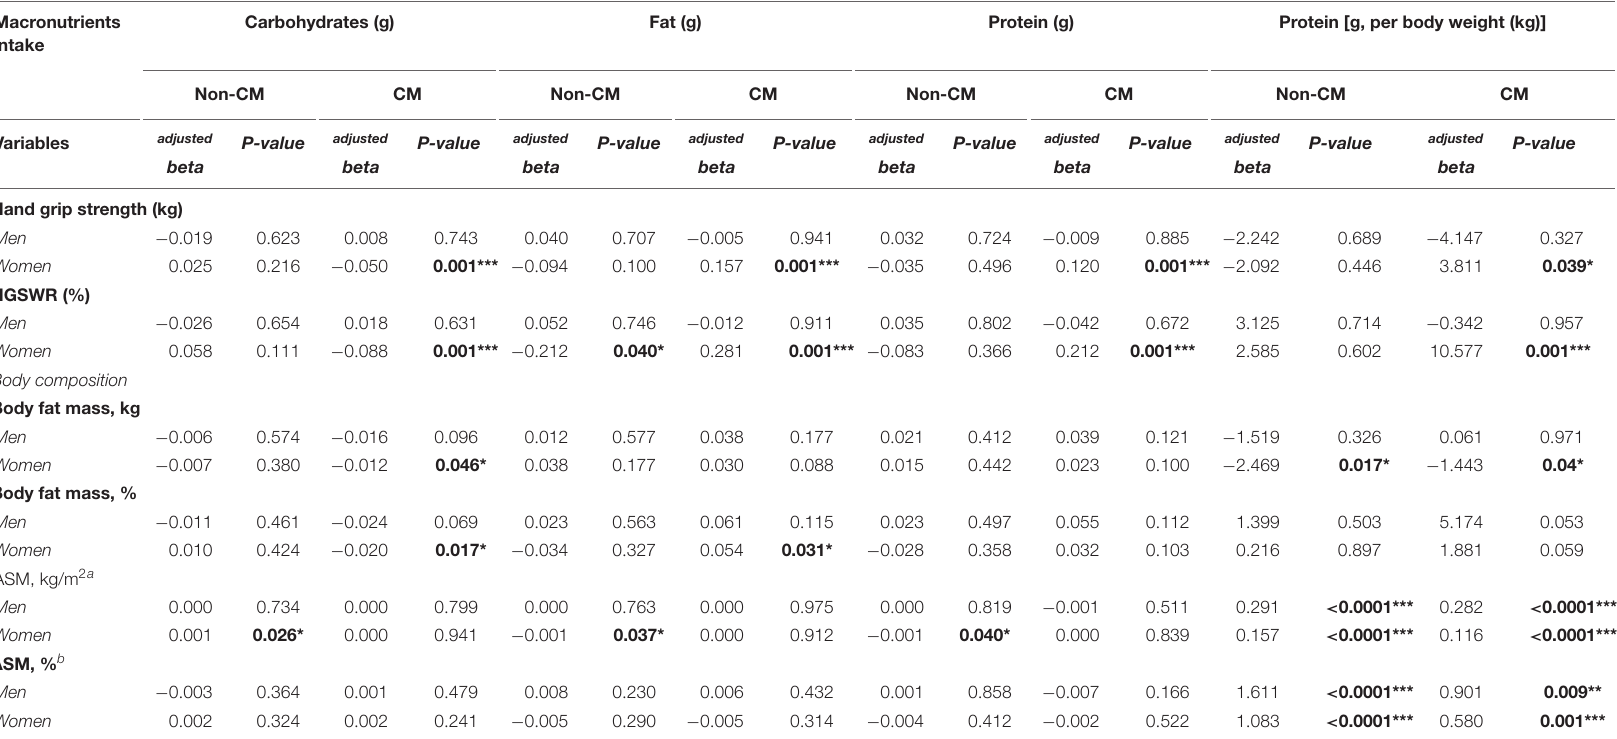
TABLE 3 | The association between macronutrients intake, handgrip strength, and body composition of the participants according to their CM pattern. Macronutrients